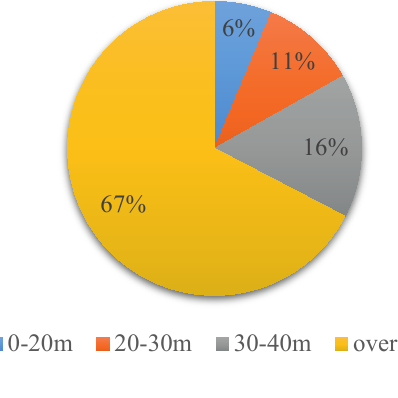
Fig. 4 . Height of